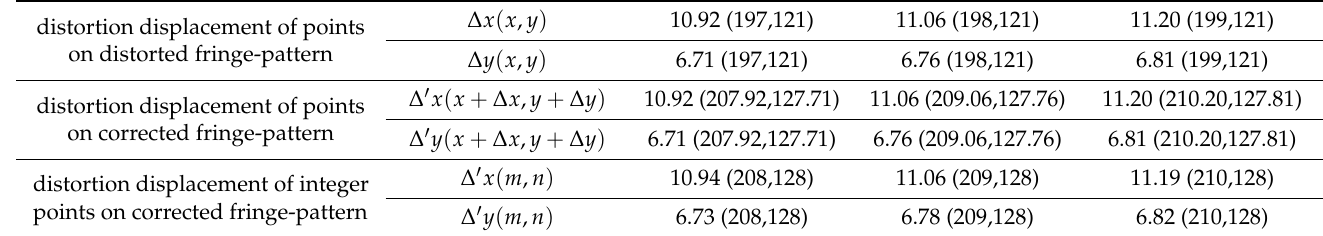
Figure 6. Modulated phase and distortion displacement. ( a ) ∆ ϕ x ( x , y ) ; ( b ) ∆ ϕ y ( x , y ) ; ( c ) ∆ x ( x , y ) ; ( d ) ∆ y ( x , y ) . Step4: Distortion displacement map calculation. We establish the discrete numer- ical correspondences of the new distortion displacement ∆ (cid:48) x and ∆ (cid:48) y with the points ( x + ∆ x , y + ∆ y ) on the corrected fringe-pattern. Table 2 shows some of the distortion displacement of the points on the distorted fringe-pattern and the corresponding points on the corrected fringe-pattern. We find that the calculated coordinates of the points on the corrected fringe-pattern ( x + ∆ x , y + ∆ y ) are not integers. So, we calculate the distortion displacement ∆ (cid:48) x ( m , n ) and ∆ (cid:48) y ( m , n ) by performing the bicubic interpolation algorithm, where ( m , n ) is the integer coordinate value of the corrected point. Table 2. Some calculated distortion displacement (pixel). distortion displacement of points on distorted fringe-pattern distortion displacement of points on corrected fringe-pattern distortion displacement of integer points on corrected fringe-pattern Step5: According to the distortion displacement map, image distortion correction can be performed by employing the inverse mapping with the bilinear interpolation directly. A numerical simulation of the distorted checkerboard is performed. Figure 7a shows the distorted checkerboard image with the same distortion parameter of λ = − 1 × 10 − 6 and distortion center ( 273, 289 ) . Figure 7b is the corrected result by the proposed method, where the red points represent the corners. Figure 8 is the corresponding corners image, where the red asterisks represent the corners of the distorted checkerboard image and the blue points represent the corners of the corrected checkerboard image. The distortion displacement at the left top point is ∆ r = 27.30 pixel. The curvature radius of the red line formed by the left points on the distorted checkerboard image is 2.2148 × 10 3 pixels, and that of the blue line corresponding to the corrected checkerboard image is 1.4731 × 10 5 pixels. It means that the circular arc is corrected to be